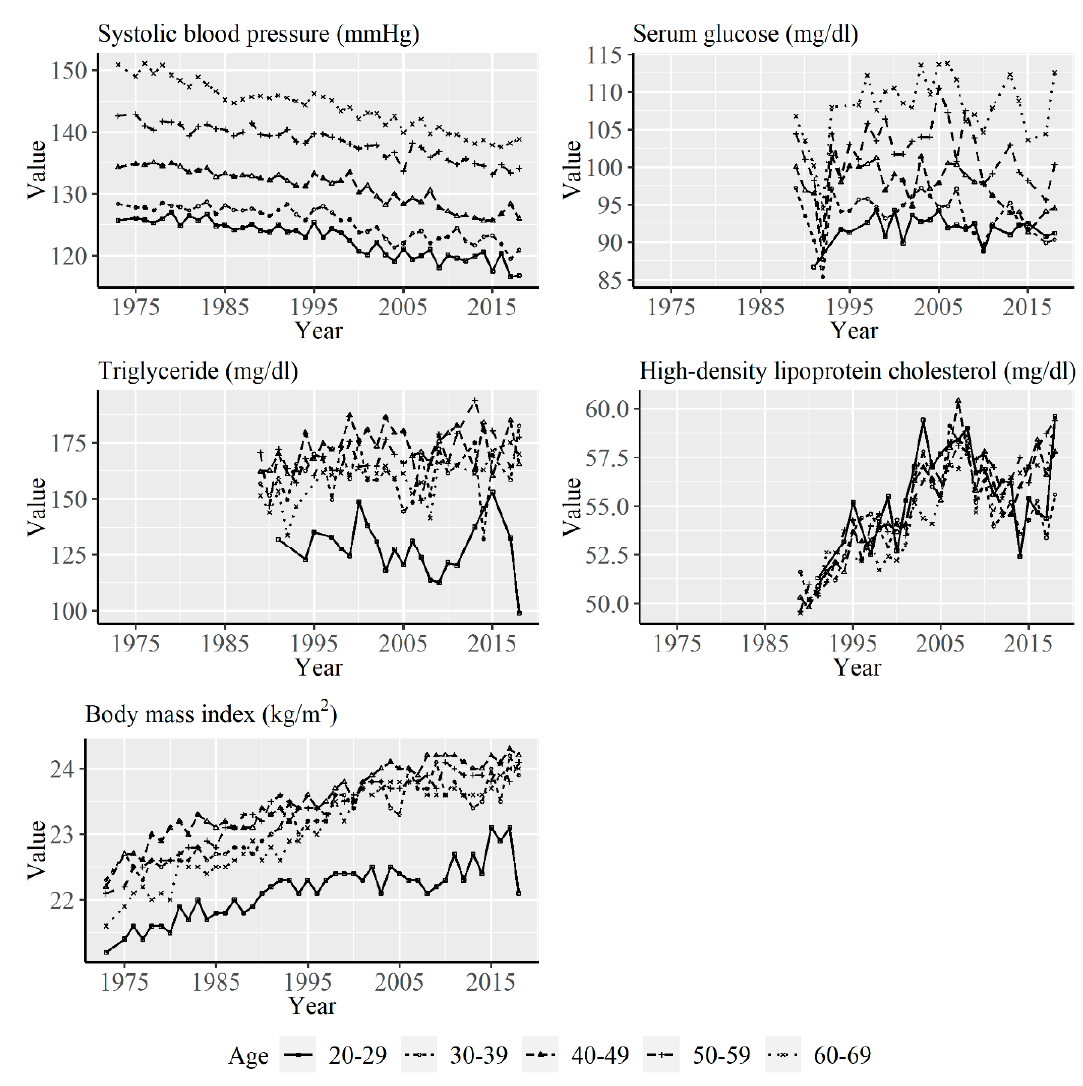
Figure 1. Yearly average values of systolic blood pressure, serum glucose, triglyceride, high-density lipoprotein cholesterol, and body mass index (BMI) according to age group among men from 1973 to 2017. Data on serum glucose, triglyceride, and high-density lipoprotein cholesterol were available from 1989.